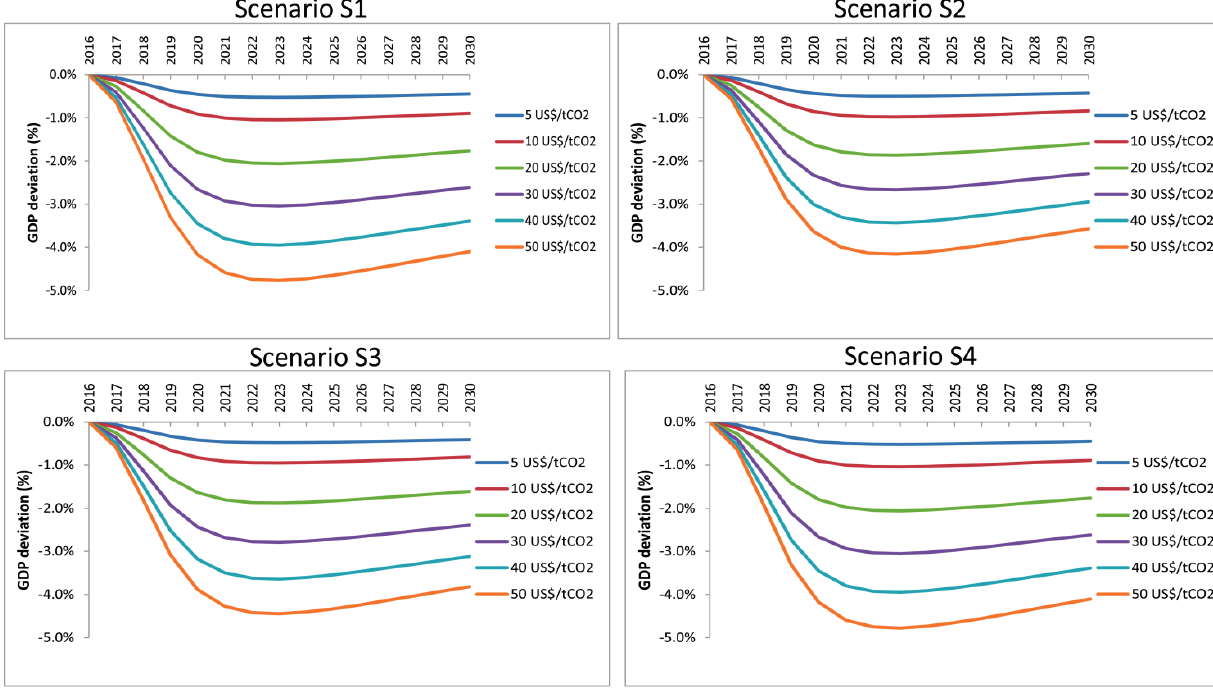
Figure 11. Effect on the level of GDP (% over baseline deviations).